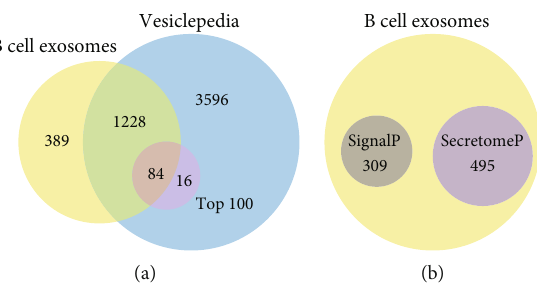
Figure 3: Venn diagrams of proteins identi fi ed in B cell exosomes. (a) Comparison of proteins identi fi ed in B cell-derived exosomes versus entire and top 100 murine proteins recorded in the Vesiclepedia database. (b) Identi fi ed proteins with prediction of classically (SignalP) and nonclassically secreted proteins